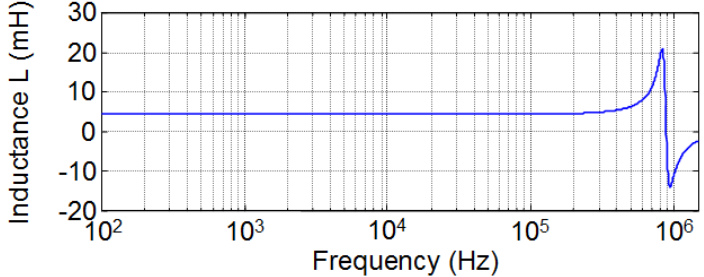
Figure 13. Inductance measurements as a function of frequency for a 28-turn RM14/I ferrite inductor.